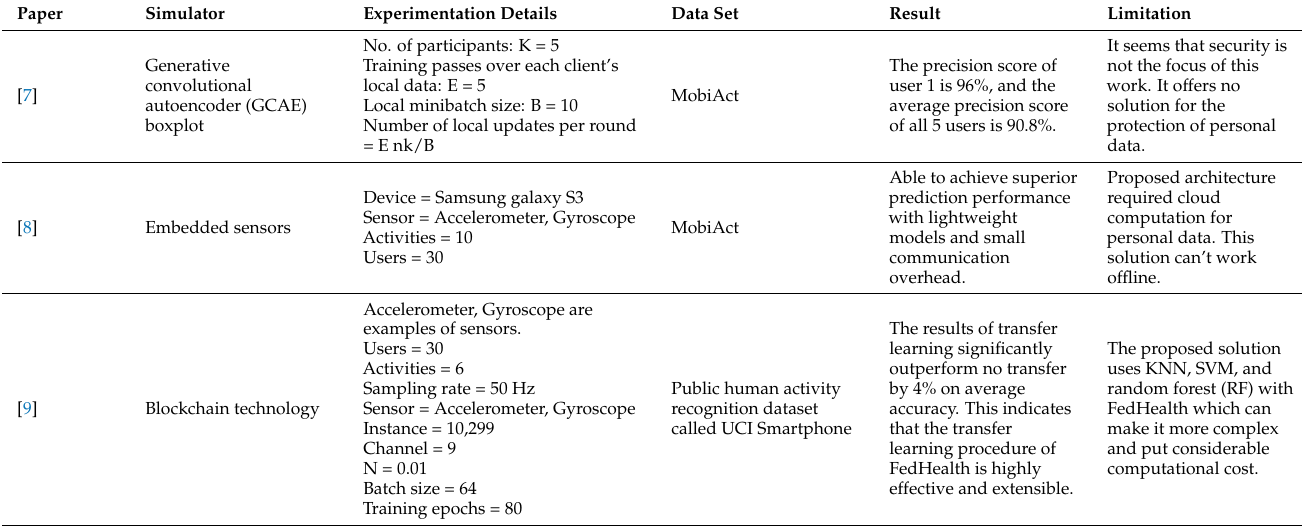
Table 1. Summary of Related